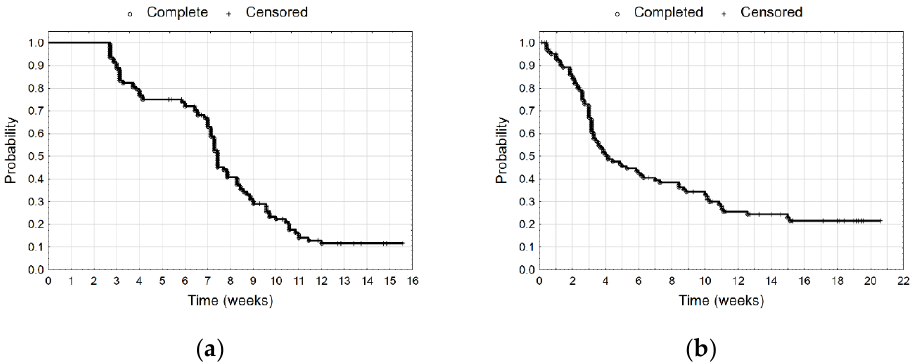
Figure 6. Kaplan–Meier estimator—probability of not reaching 20% decline ( a ) and increase ( b ) in values of the stock indices. Source: own elaboration, Statistica.